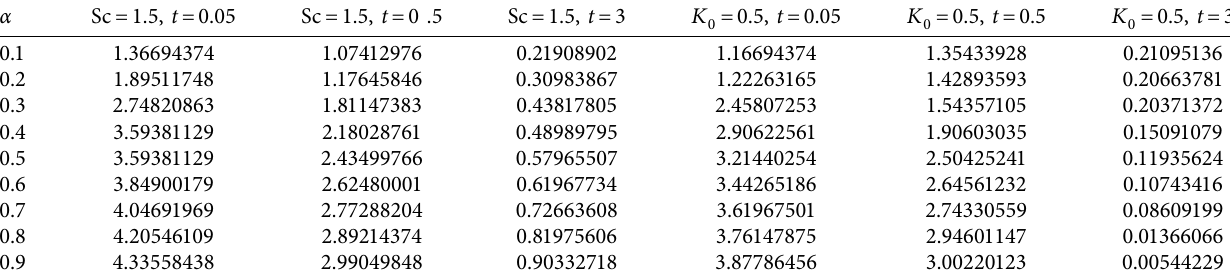
Table 2: Subjectivity of Sherwood number due to α